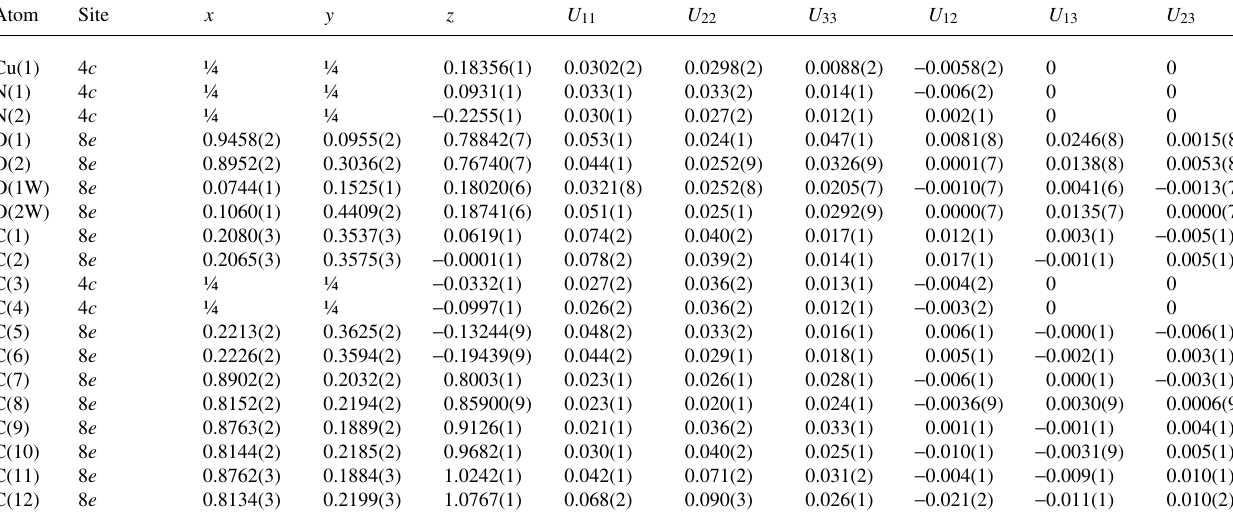
Table 3. Atomic coordinates and displacement parameters (in Å 2 )